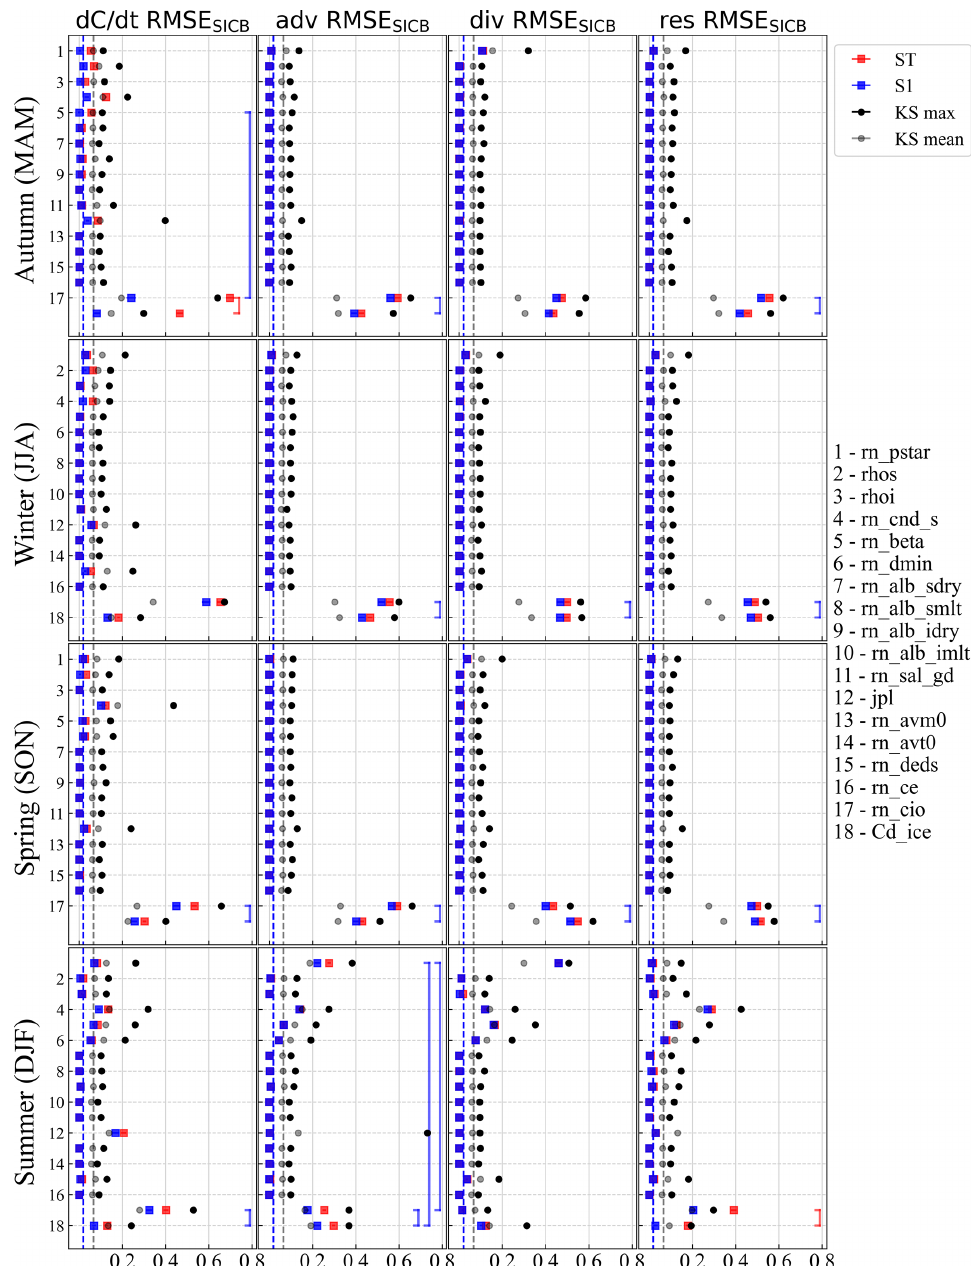
Figure 9. The same as Fig. 8 but for the sensitivity of the RMSE between SIC budgets of the model and the observational data to 18 parameters. The red connecting lines are the same as the blue ones but for the Sobol second-order index larger than